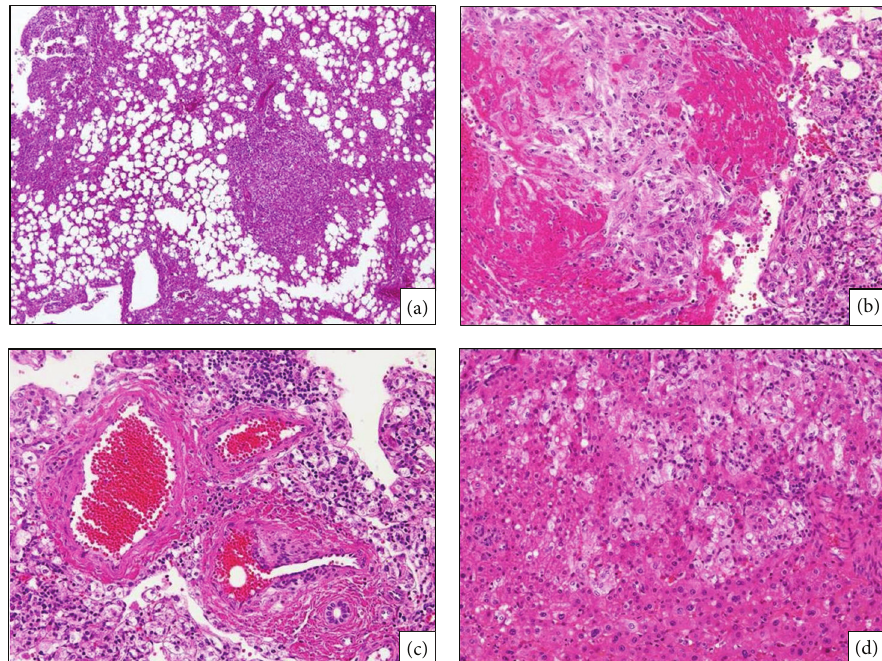
Figure 4: Histological findings (HE staining): the tumor included mature fat, blood vessels, and epithelioid-spindle cells ( × 120) (a). A part of the tumor showed predominance of spindle cells and blood vessel ( × 120) (b) ( × 300) (c). The tumor showed invasive growth pattern ( × 300) (d).